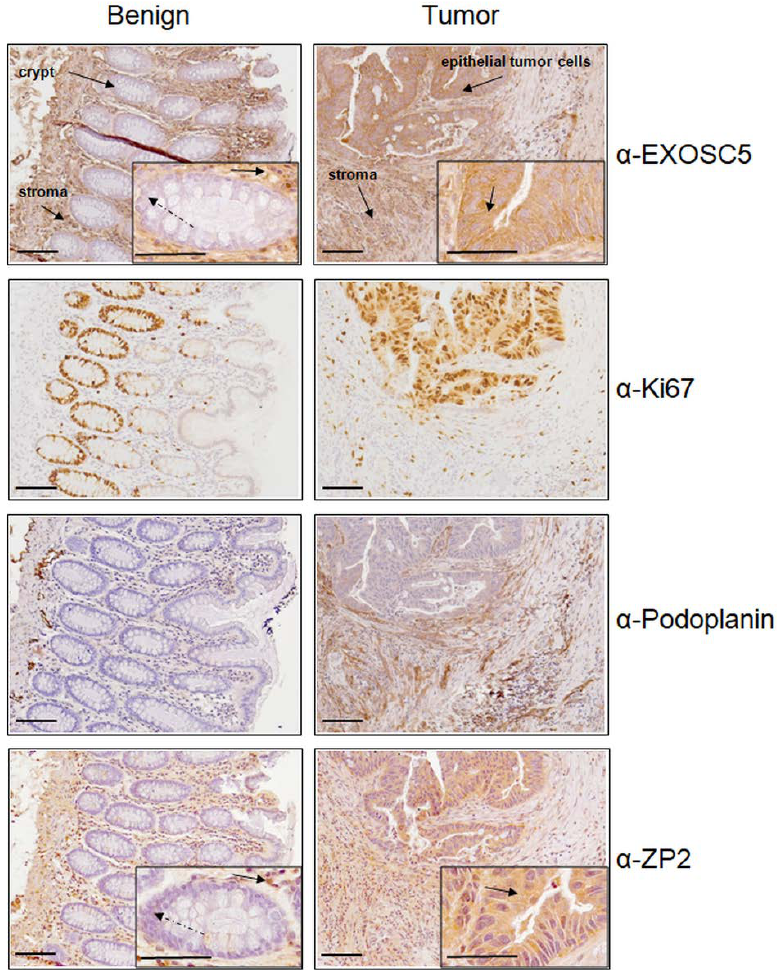
Figure 5. Representative EXOSC5-, Ki67-, podoplanin-, and ZP2-immunostaining in human tissues. On the left, case-wise matched benign colon mucosa, the right panel shows consecutive sections of the corresponding colon carcinomas (all 200×, bar represents 100 µm). Antigen-positive cells are stained in brown; antigen-negative cells are counterstained in blue. Insets with a higher magnification show antigen-positive cells marked with a black arrow and antigen-negative cells marked with a dashed arrow (all 400×, bar represents 100 µm).